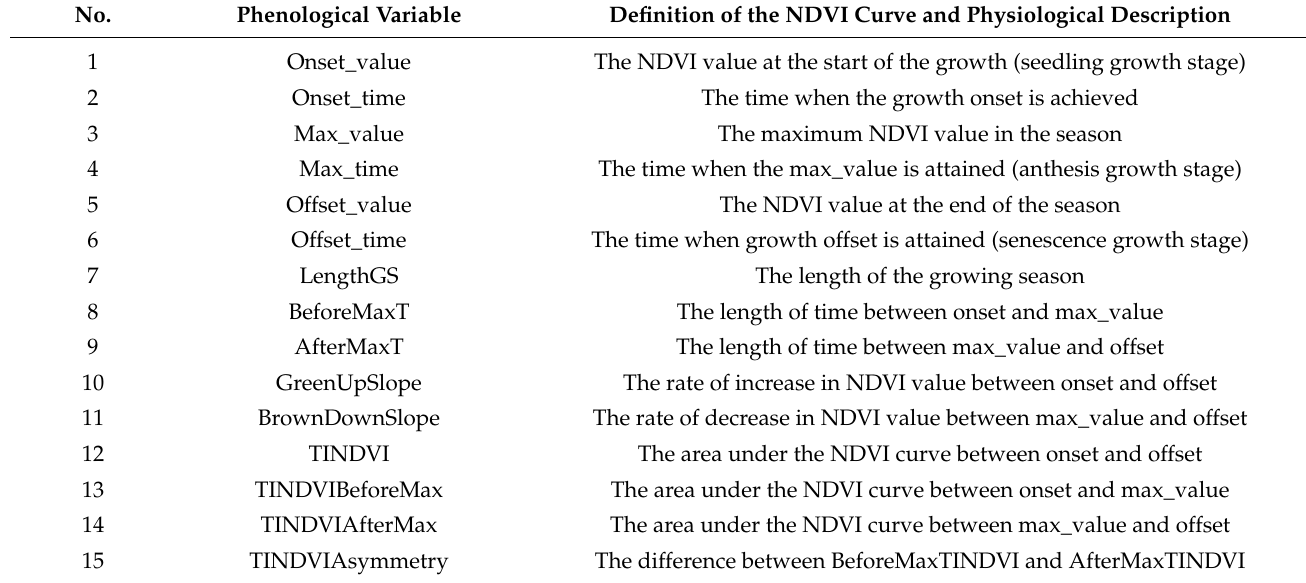
Table 4. Description of vegetation phenological variables derived in the present